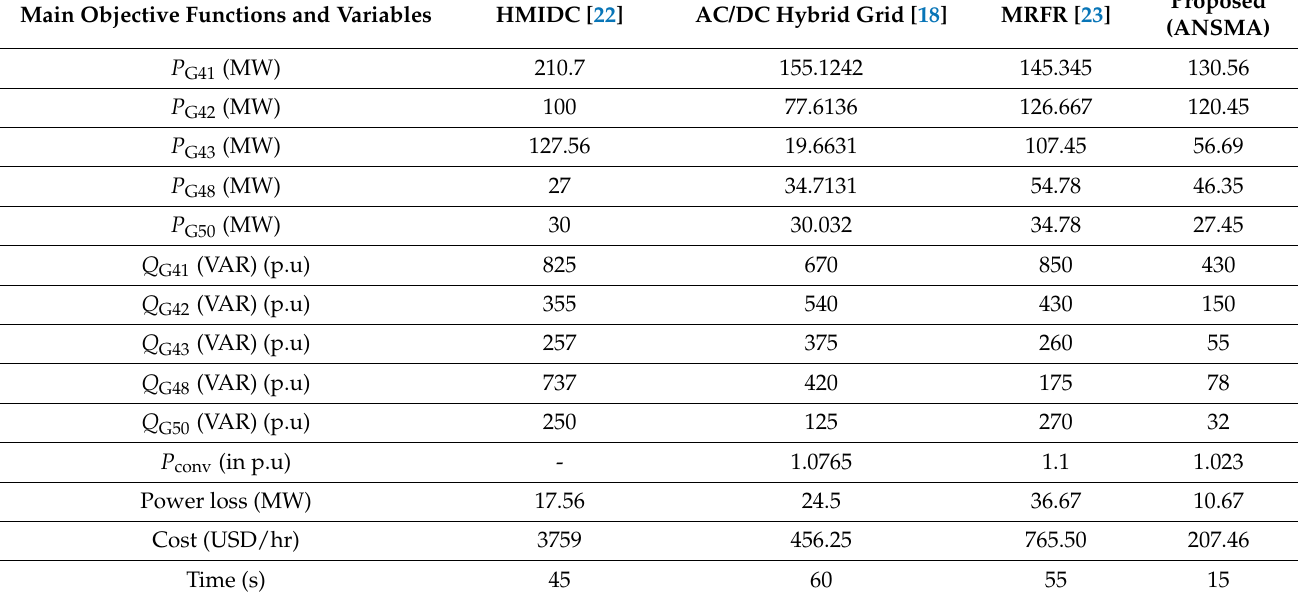
Table 1. Performance comparison of power flow of the proposed ANSMA model with those of existing methods in IEEE 50-bus system.